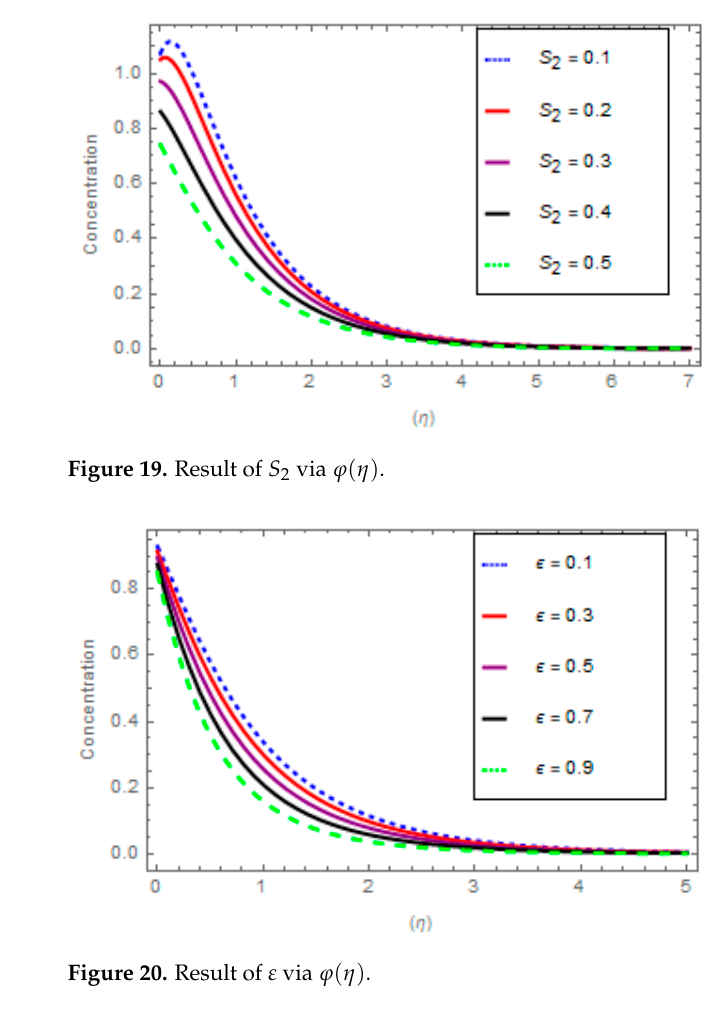
Figure 20. Result of ε via ϕ ( η ) .